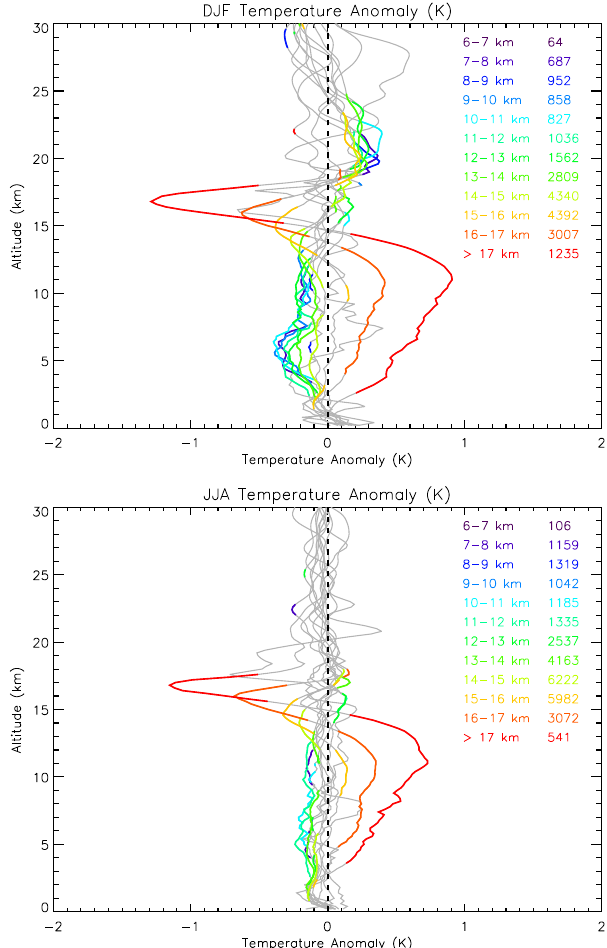
Fig. 6. Average temperature anomaly profiles for GPS soundings within ± 6 hours and 1000 km of a maximum deep convective cloud greater than 17 km (red), between 16-17 km (orange), between 15-16 km (yellow), and so on, during (top) DJF and (bottom) JJA. Anomalies that exceed the 99% significance level appear in color. The number of profiles that go into each anomaly profile is given on the right side of the figure.